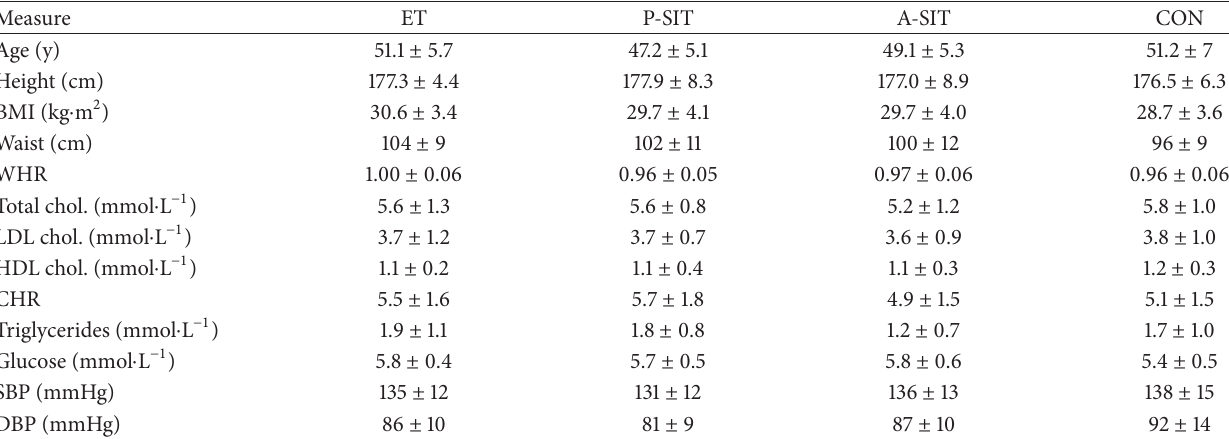
Table 1: Baseline subject